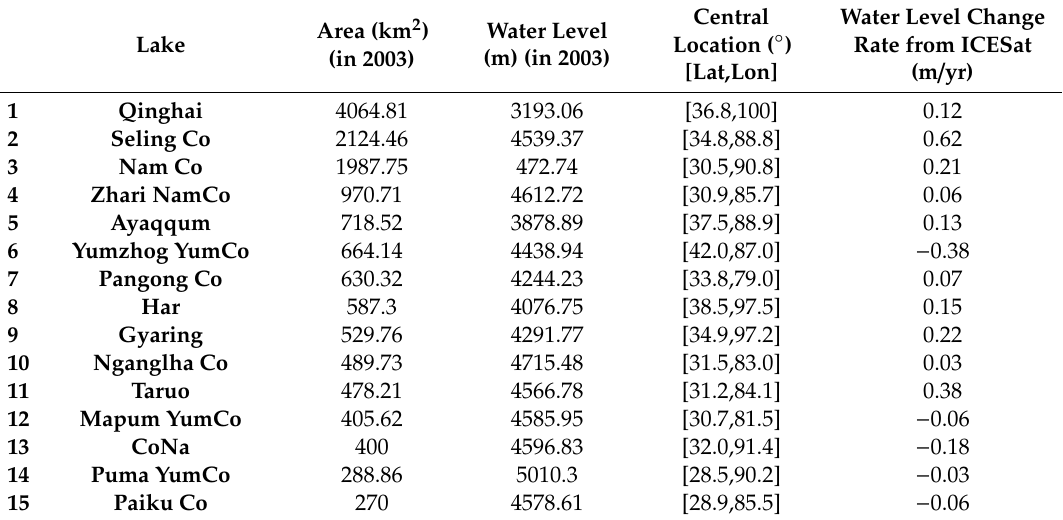
Table 2. Geographic information of 15 selected major lakes on the Tibetan Plateau and their water level changes from processing the ICESat data over the period from March 2003 to October